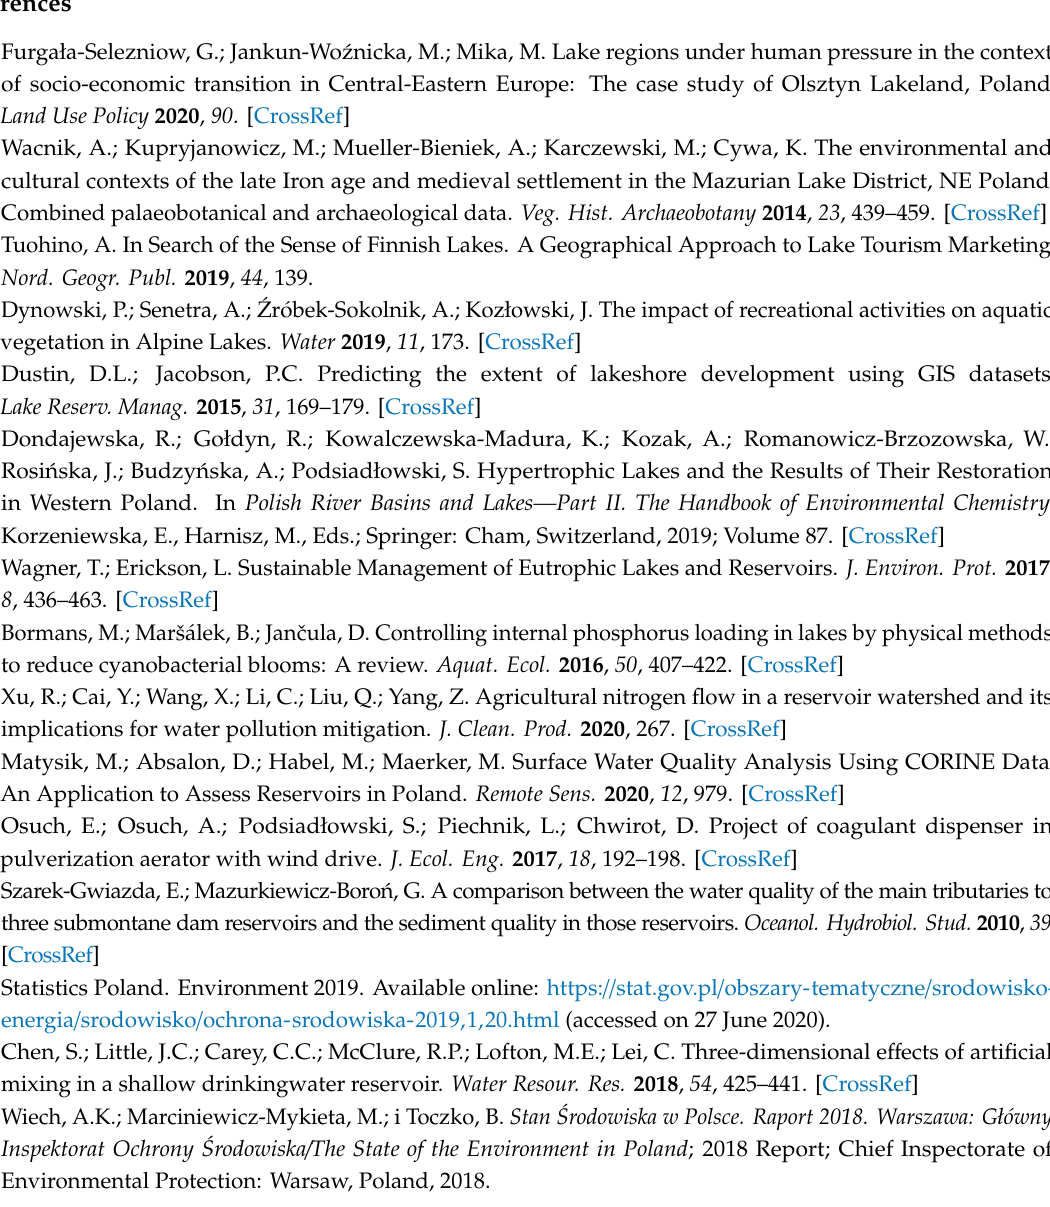
Table S1: Tukey post hoc tests—for ANOVA analysis